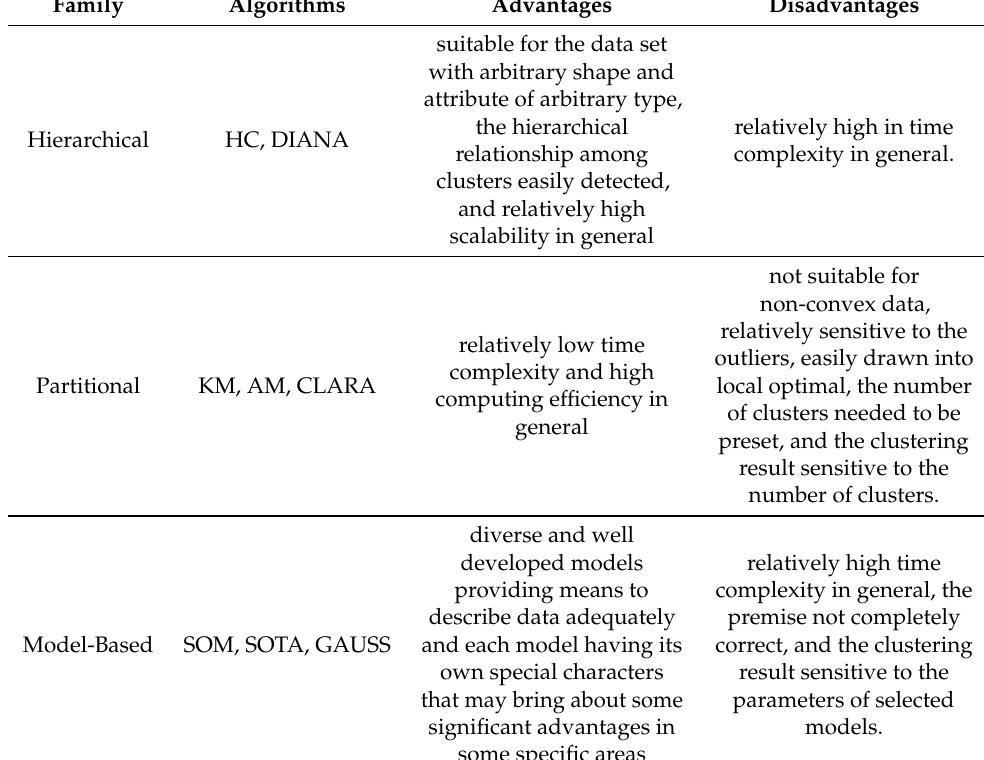
Table 1. Advantages and disadvantages of clustering algorithms used in this